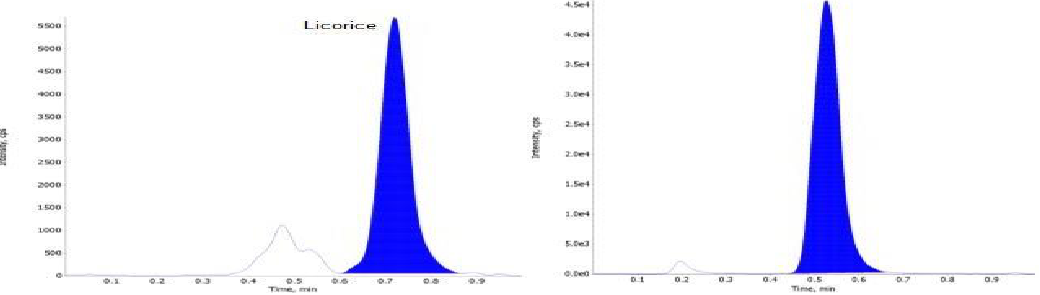
Figure 2c. Montelukast combined with licorice with candesartan (IS)